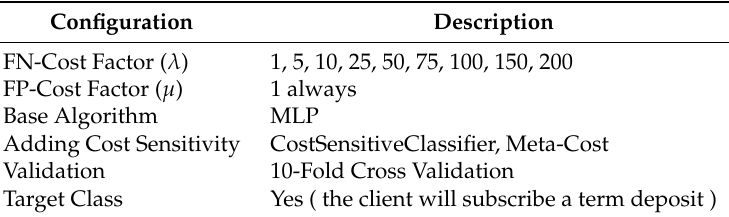
Table 4. Experiment